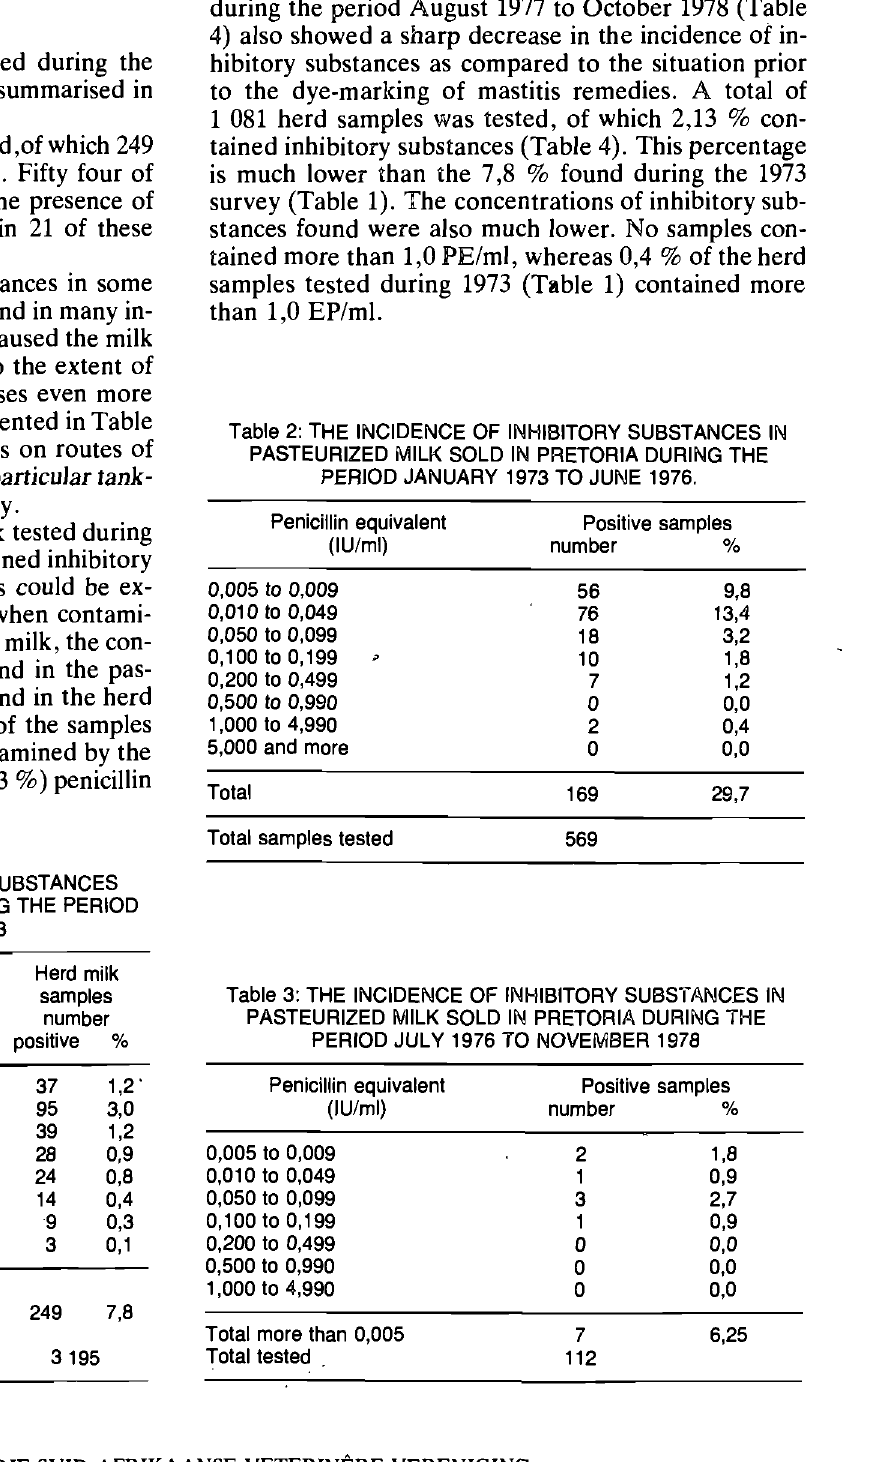
Table 3: THE INCIDENCE OF INHIBITORY SUBSTANCES IN PASTEURIZED MILK SOLD IN PRETORIA DURING